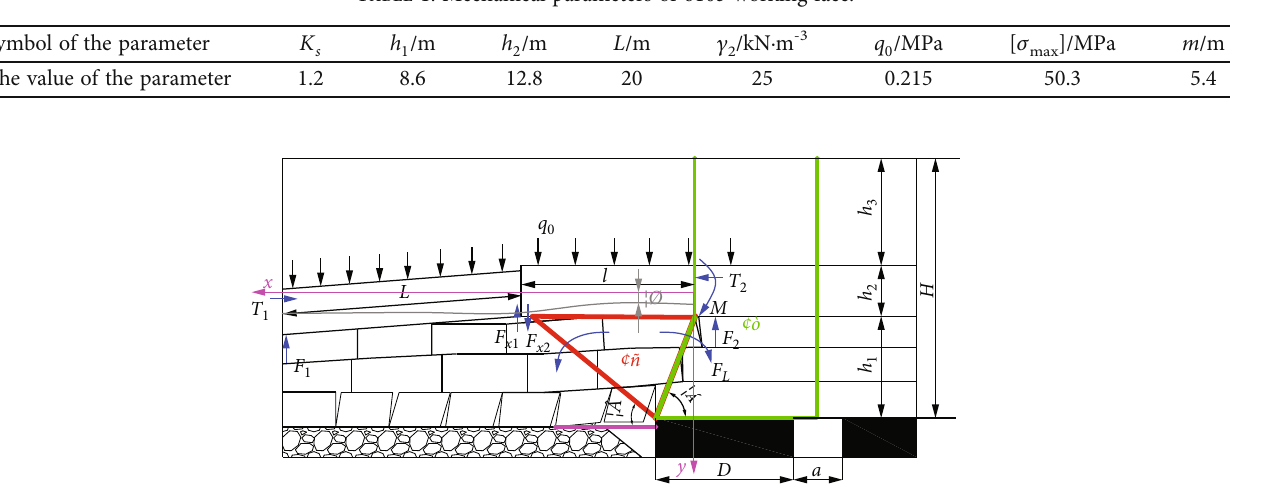
Figure 2: Spatial structure and mechanical model of stopping mining coal